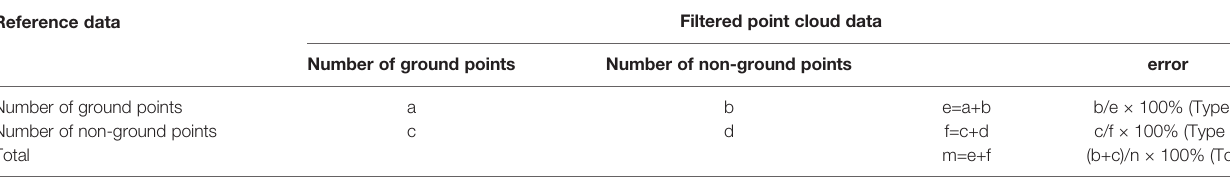
TABLE 2 | Error calculation formula.